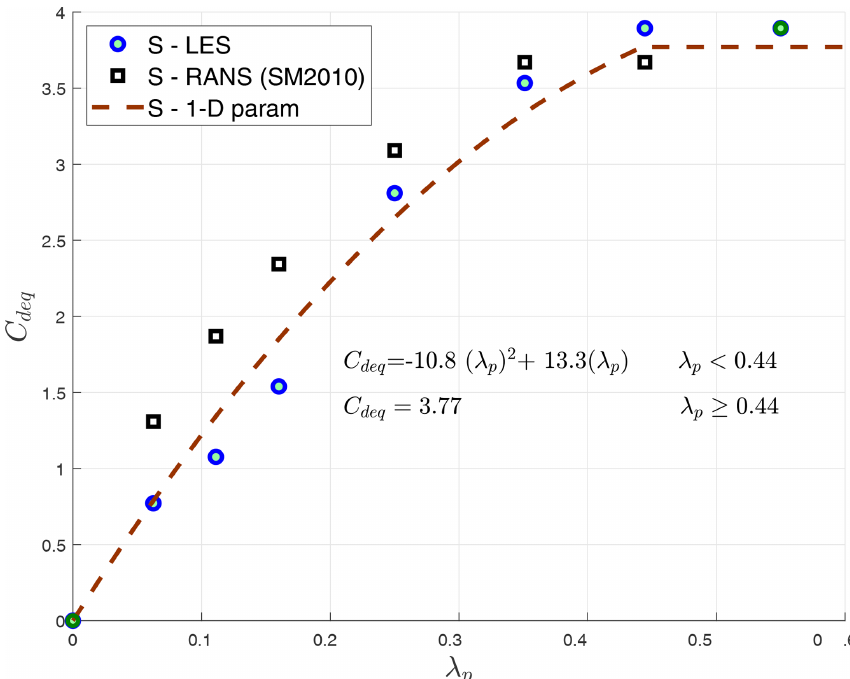
Figure 8. Variation of C deq with urban packing density λ p for the staggered configuration and compared with the RANS results of Santiago and Martilli (2010). The fitted line indicates the parameterization proposed for the 1-D model. Additional data points (in green) are added for parameterization corresponding to λ p = 0 (zero building-induced drag) and λ p > 0 . 44 (where the drag coefficient reaches a constant value for high urban packing